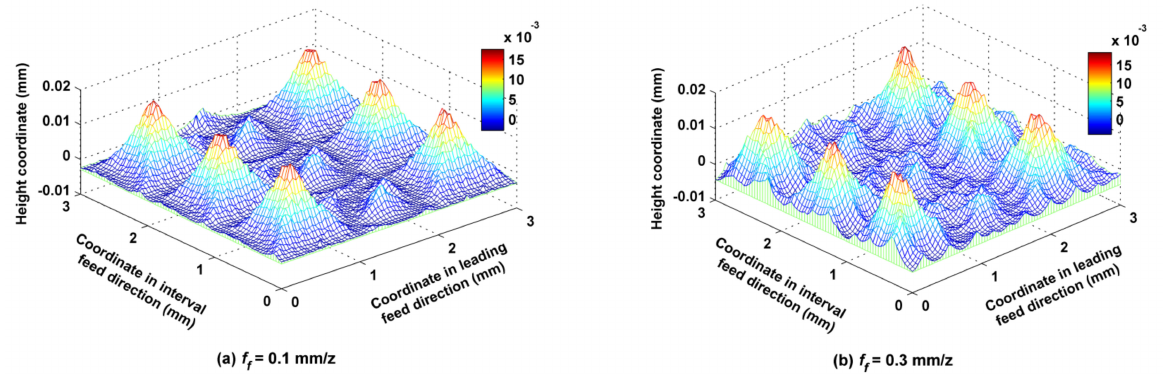
Figure 16. Ball-end trochoidal milling micro surface topography comparisons between different feeds per tooth.